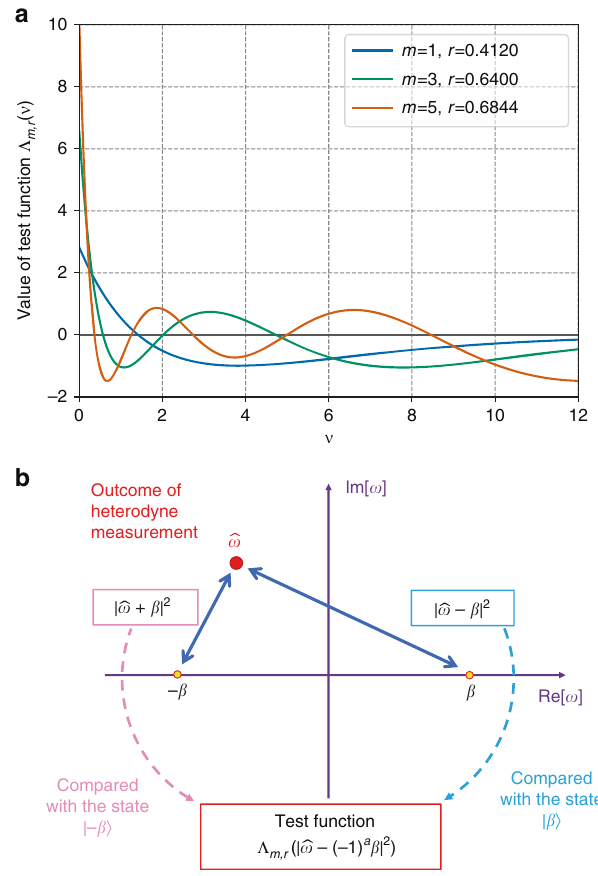
Fig. 1 The test scheme to estimate the fi delity. a Example of the test functions Λ m , r used in the estimation. The values of r in the fi gure are chosen so that the range of Λ m , r is minimized for given m . In general, the minimum range of the function Λ m , r becomes larger as m increases. The pair ( m , r ) = (1, 0.4120) was used in the numerical simulation of key rates below. b A schematic description of the usage of obtained outcomes in heterodyne measurement. In order to estimate the lower bound on the (cid:5) (cid:6) (cid:5) fi delity to the coherent states ± β , the squared distance between the outcome ^ ω and the objective point ( − 1) a β (i.e., j ^ ω (cid:2) ð(cid:2) 1 Þ a β j 2 ) is